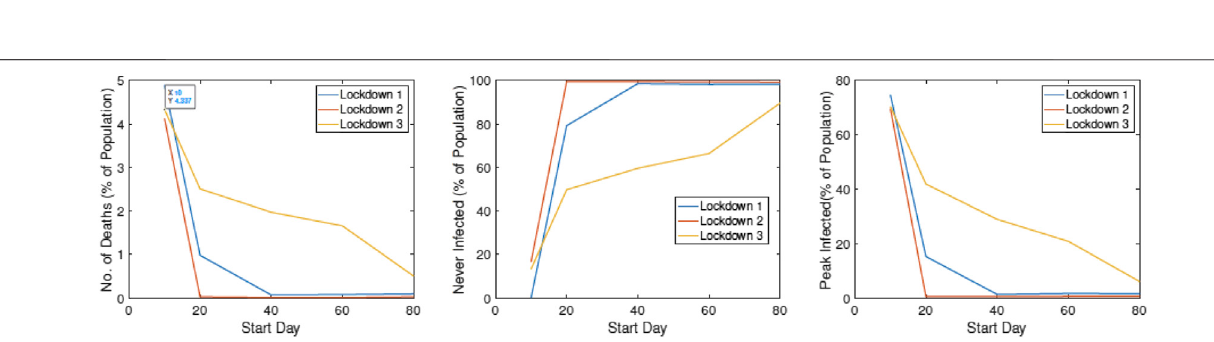
Frontiers in Applied Mathematics and Statistics |